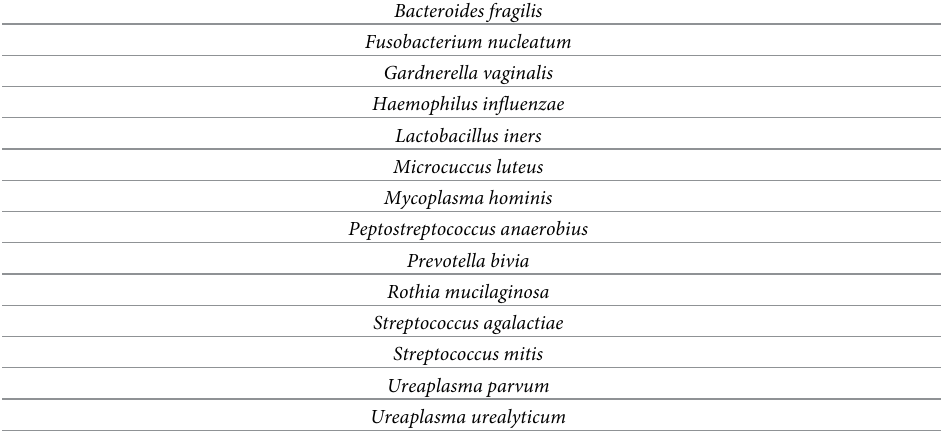
Table 2. Microorganisms associated in the literature with chorioamnionitis, early onset neonatal sepsis and/or preterm